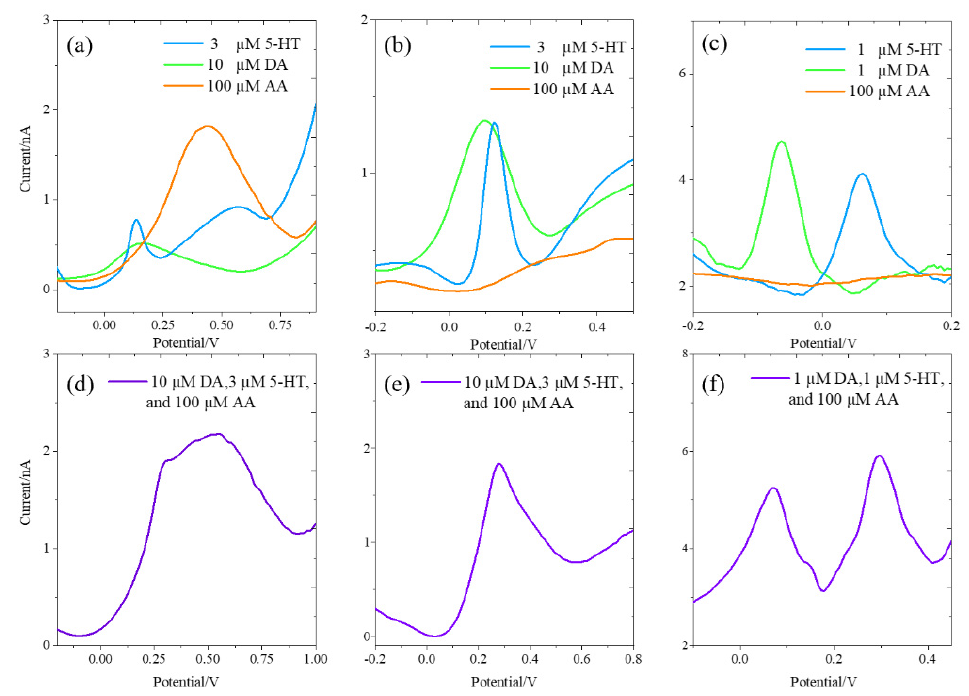
Figure 6. Differential pulse voltammetry (DPV) plots of the unmodified ( a , d ), nafion-modified ( b , e ), and nafion–MWCNT-modified ( c , f ) BDUNCD microelectrodes using individual analytes ( a – c ) and ternary mixture ( d – f ) in the solution. For nafion–MWCNT-modified BDUNCD microelectrodes, lower concentrations of DA and serotonin (5-HT) were used. Table 3. Comparison of DPV peak currents from individual (single component) analytes (1 μ M DA, 1 μ M 5-HT, and 100 μ M ascorbic acid (AA)).